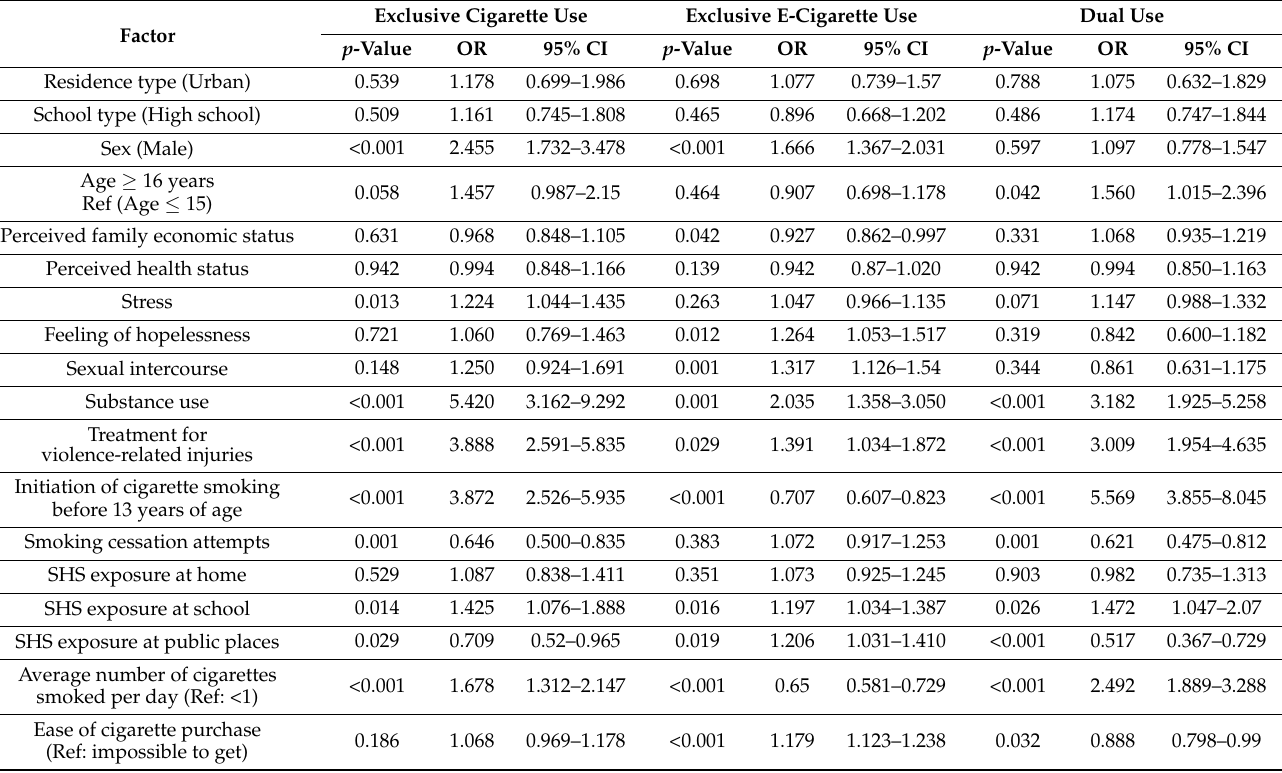
Table 2. Factors associated with current cigarette, e-cigarette, and dual